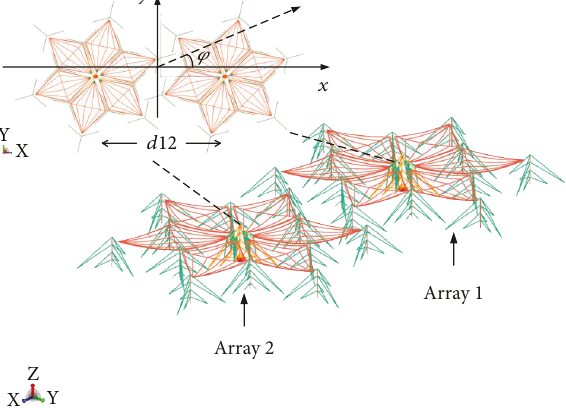
Figure 8: The model of the VLF umbrella antenna